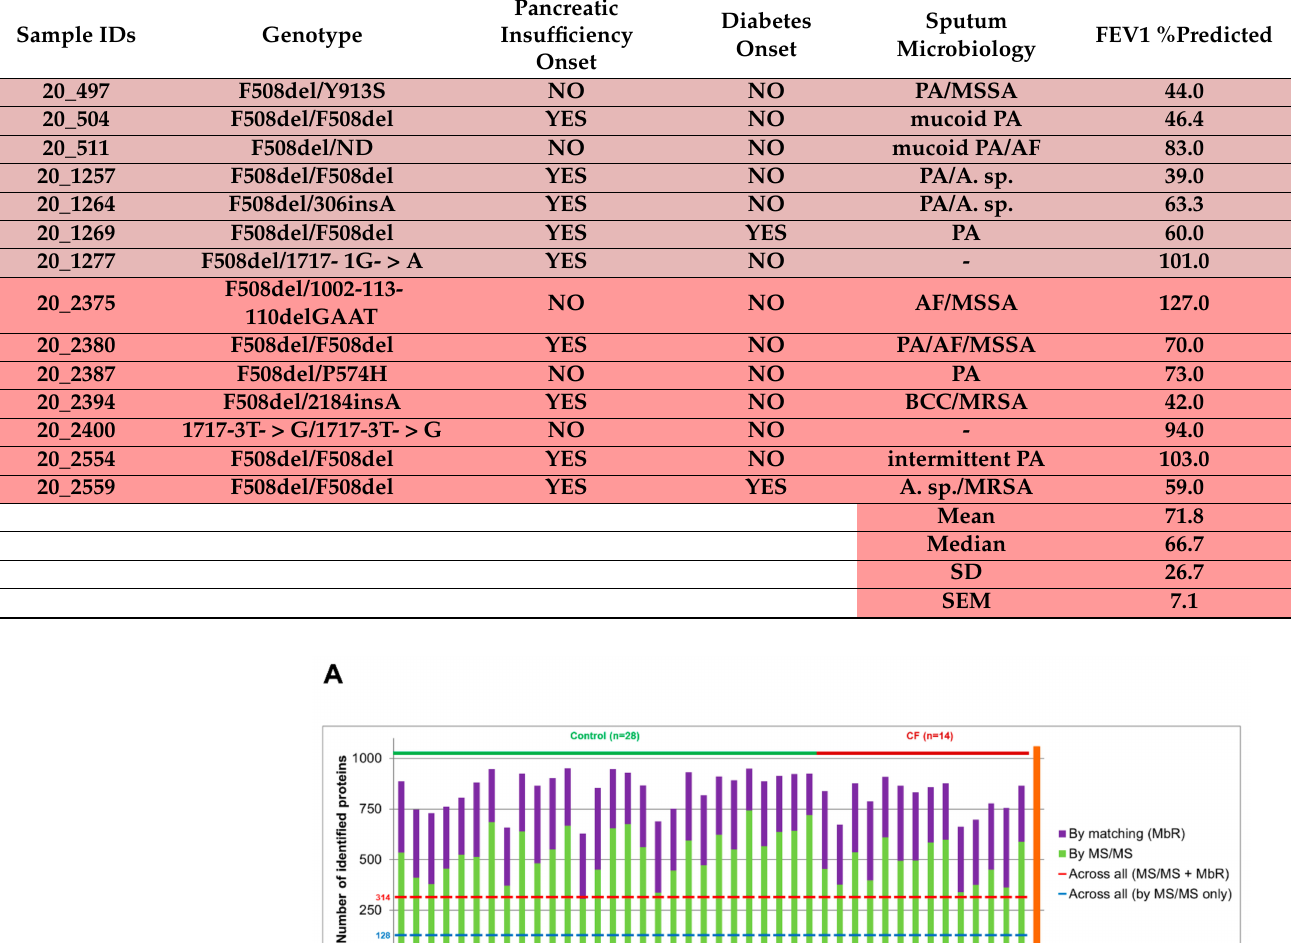
Table 2. Clinical data summary: genotype, clinical manifestations, and spirometry of patients with CF. PA, Pseudomonas aeruginosa , MSSA, meticillin-sensitive Staphylococcus aureus , MRSA, meticillin- resistant Staphylococcus aureus , AF, Aspergillus fumigatus , A. Sp., Achromobacter species, BCC, Burkholde- ria cepacia complex. Red shades of background color indicate the different analytical series.